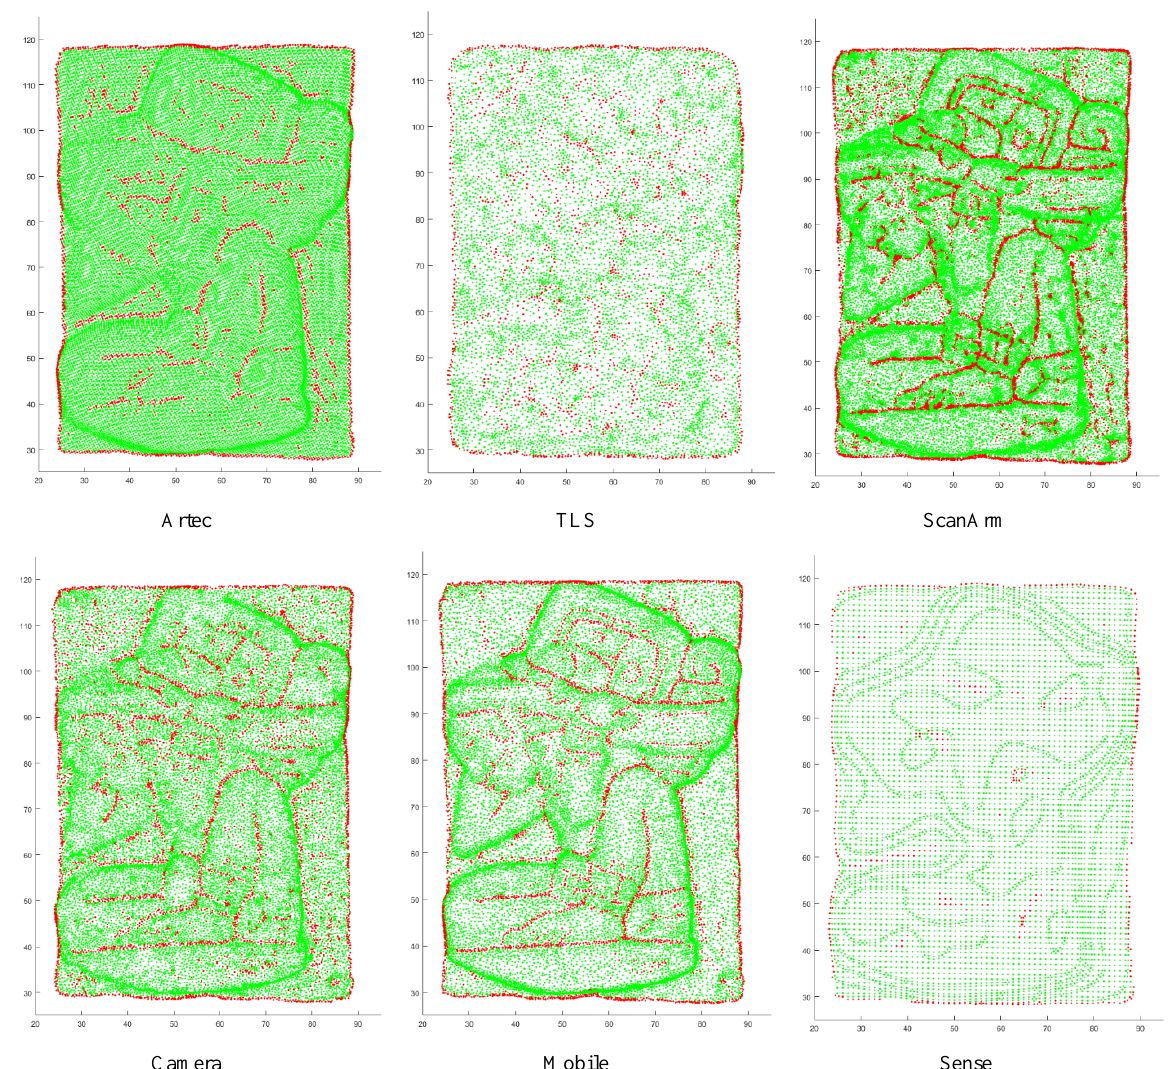
Figure 9. Local minimum maps; red - deep points, green - non-deep